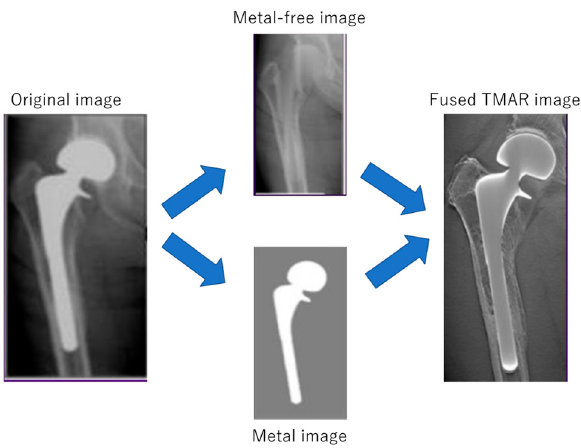
Figure 2. Brief image of tomosynthesis with metal artifact reduction (TMAR). Projection images were initially separated into metal and metal-free images. These images were iteratively reconstructed to reduce metal artifacts and were then fused to create TMAR images.